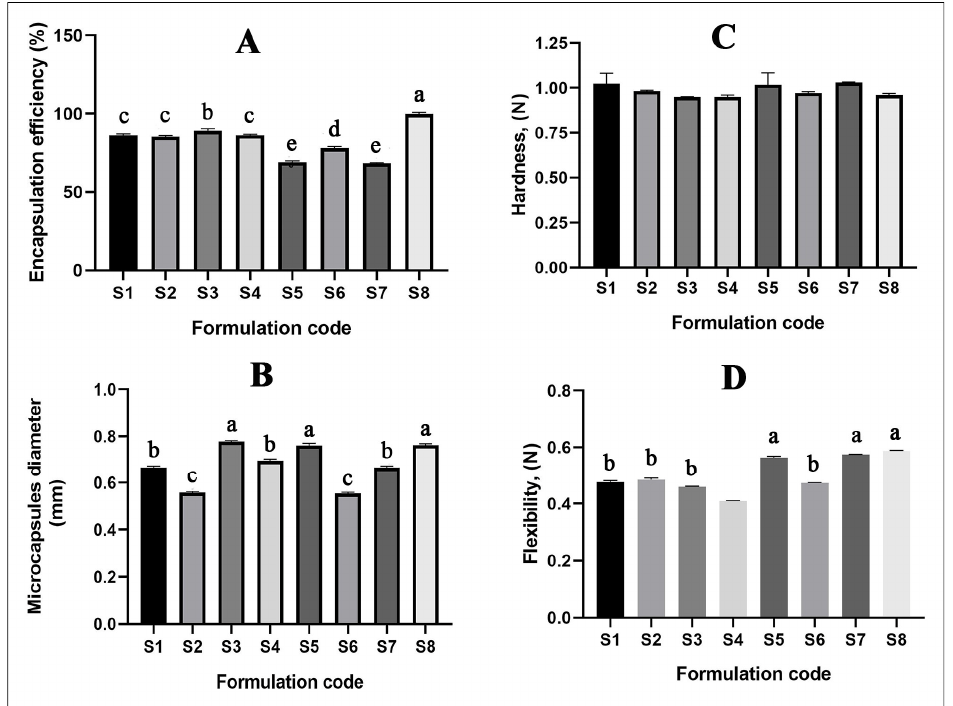
Figure 5. ( A ) The encapsulation efficiency of oregano essential oil-loaded microcapsules. Data represent means ± SD, n = 6. Different letters in each column denote a statistical difference at p ≤ 0.05.; ( B ) The diameter of oregano-loaded microcapsules. Different letters in each column denote a statistical difference at p ≤ 0.05. Data represent means ± SD, n = 6.; ( C ) The hardness (N) of oregano-loaded microcapsules, there was no statistical difference, p > 0.05. Data represent means ± SD, n = 6. ( D ) The flexibility (N) of oregano-loaded microcapsules. Different letters in each column denote a statistical difference at p ≤ 0.05 (B). Data represent means ± SD, n = 6.